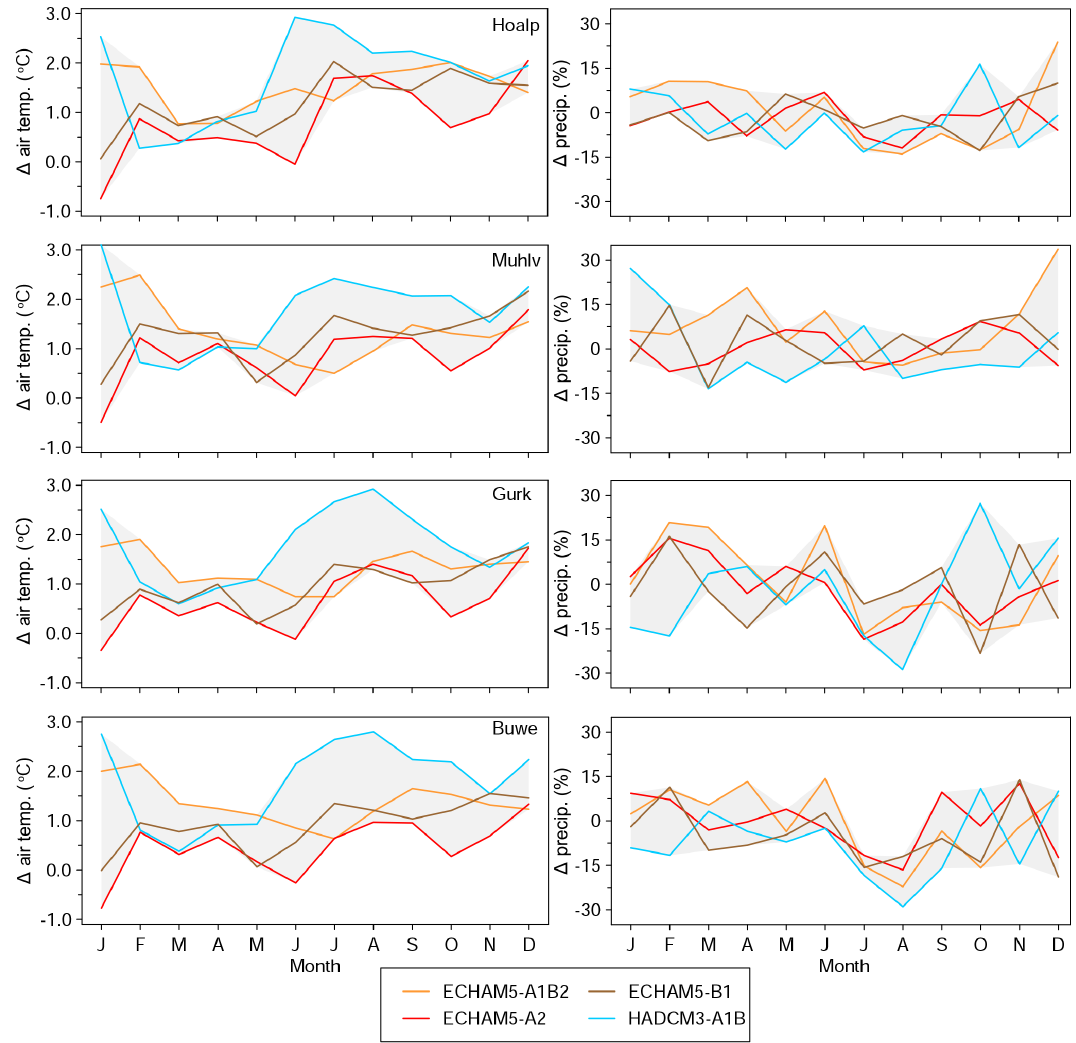
Figure 5. Projections of air temperatures and precipitation for the four catchments simulated by regional climate models. Shown are long- term monthly changes of the future period (2021–2050) relative to the reference period (1976–2008). Shaded areas indicate the range of climate